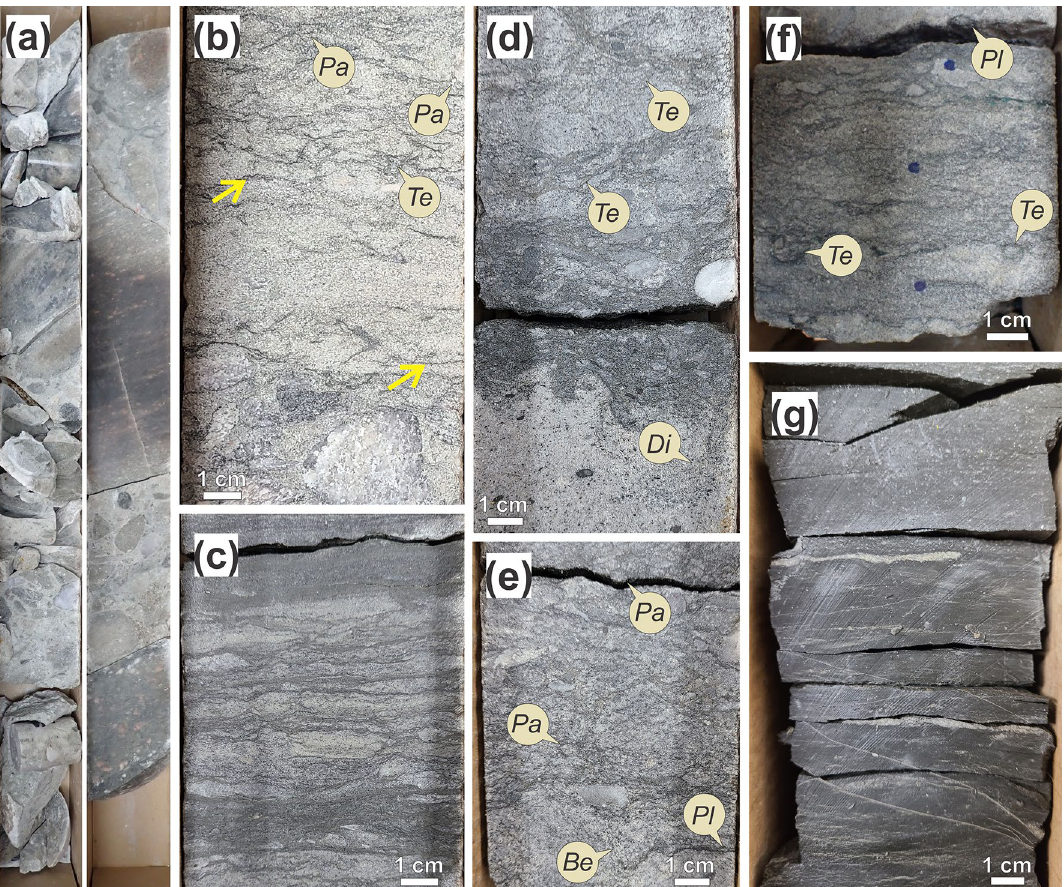
Figure 2. Trace fossils and sedimentary facies of Facies Association 1 (FA1). ( a ) General view of granule to boulder conglomerate (Cg). Core width 7.5 cm. ( b ) Teichichnus rectus ( Te ) and Palaeophycus isp. ( Pa ) in interbedded sandstone and conglomerate (S-Cg). Sandstone bed is mudstone draped (yellow arrows) forming flaser and wavy bedding. ( c ) Argillaceous sandstone and mudstone (Sd). ( d ) Teichichnus rectus ( Te ) and poorly defined Diplocraterion isp. ( Di ) penetrating in bioturbated gravelly sandstone (Sg-bio). ( e ) Palaeophycus isp. ( Pa ) and Planolites isp. ( Pl ) in bioturbated gravelly sandstone (Sg-Bio). Bergaueria isp. ( Be ) preserved at base of sandstone layer. ( f ) Teichichnus rectus ( Te ) and Planolites isp . ( Pl ) in argillaceous sandstone and mudstone (Sd). ( g ) Parallel-laminated shale (Sh). Photographs taken by A.I. Labels created by A.I. using CorelDRAW